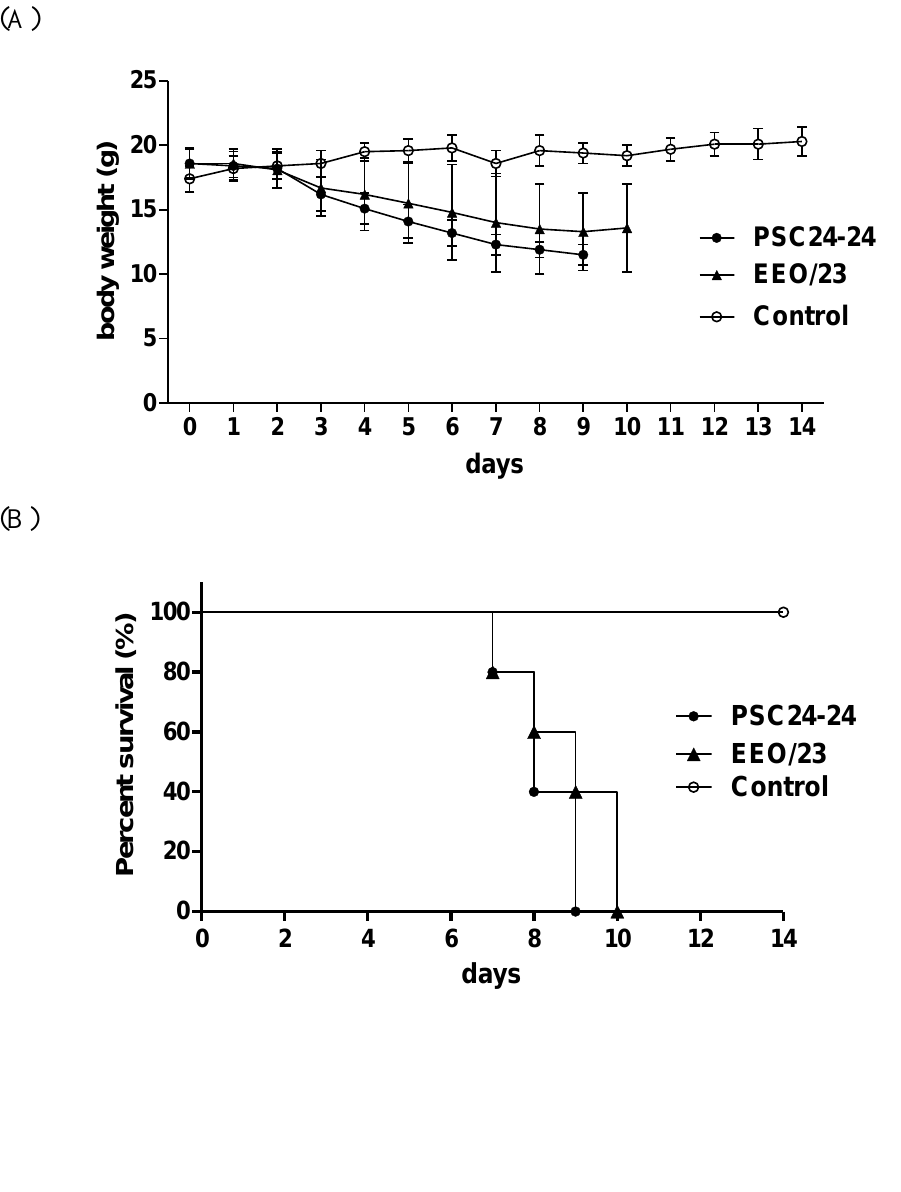
Figure 3. Body weight changes and survival curves of mice. Five mice were inoculated with 10 6.0 EID /50 μl of A/mandarin duck/Korea/PSC24-24/2010 (PSC24-24) and 50 A/Eurasian eagle owl/Korea/23/2010 (EEO/23), respectively, and observed for 14 days. ( A ) When comparing the body weight of the mice, the weight of the PSC24-24-inoculated group was significantly different from that of the control group after 3 dpi and that of the EEO/23 group was significantly different after 4 dpi (ANOVA, p<0.05). ( B ) All 5 of the mice in each group died within 10 days. When comparing the survival curves of the two viruses, there was no significant difference between the two viruses (log-rank test, p=